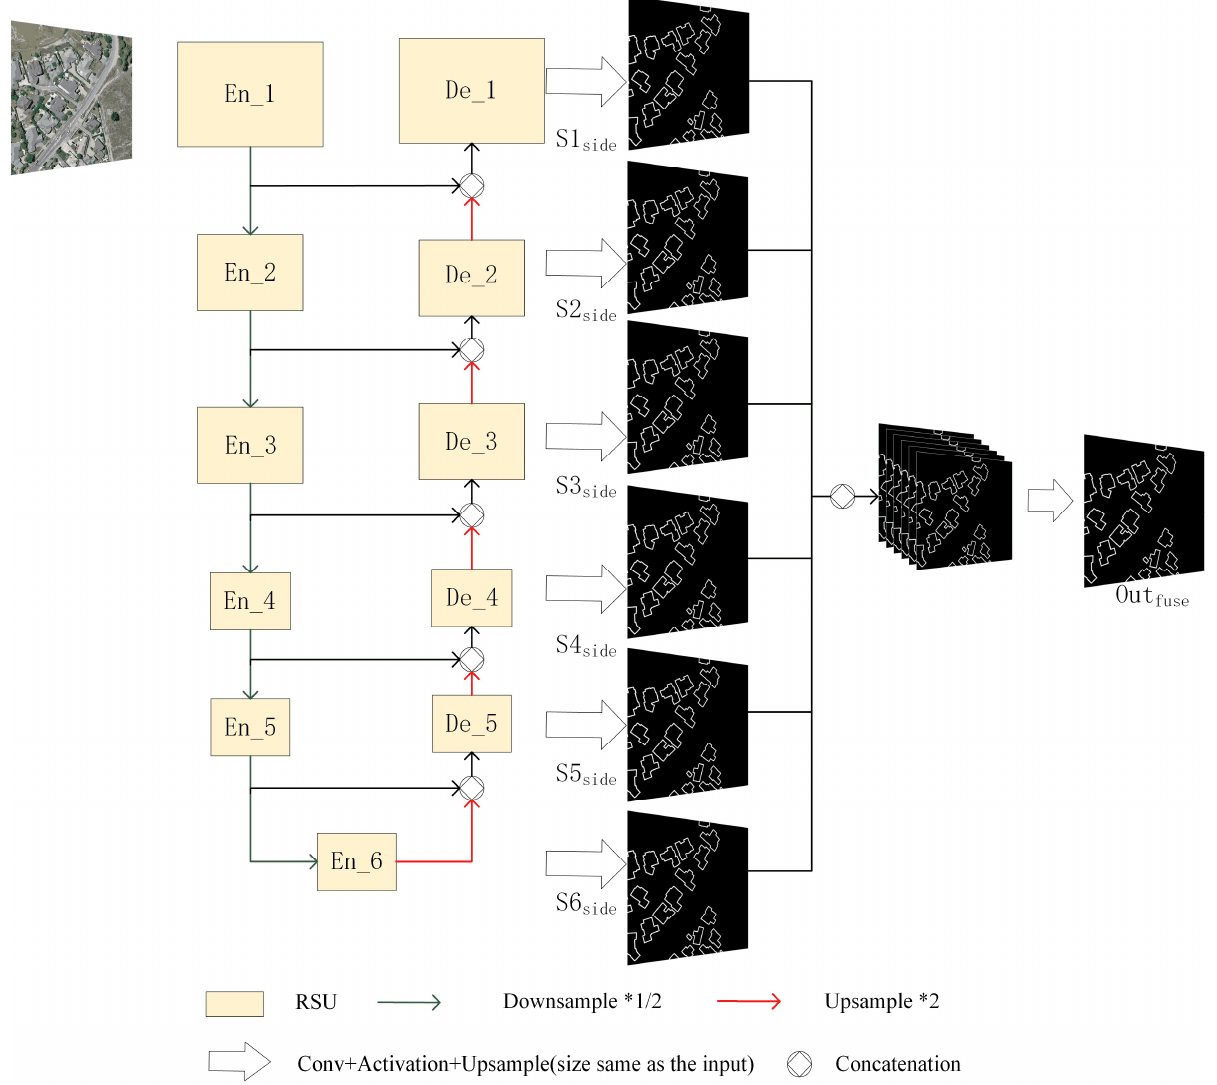
Figure 1. U 2 -net architecture [52]. The network as a whole is a U-shaped structure, the basic unit is RSU, the decoder and the last encoder, respectively, produce side output, and the side output is merged in the channel direction and then passed through the convolutional layer to produce the fused output result.